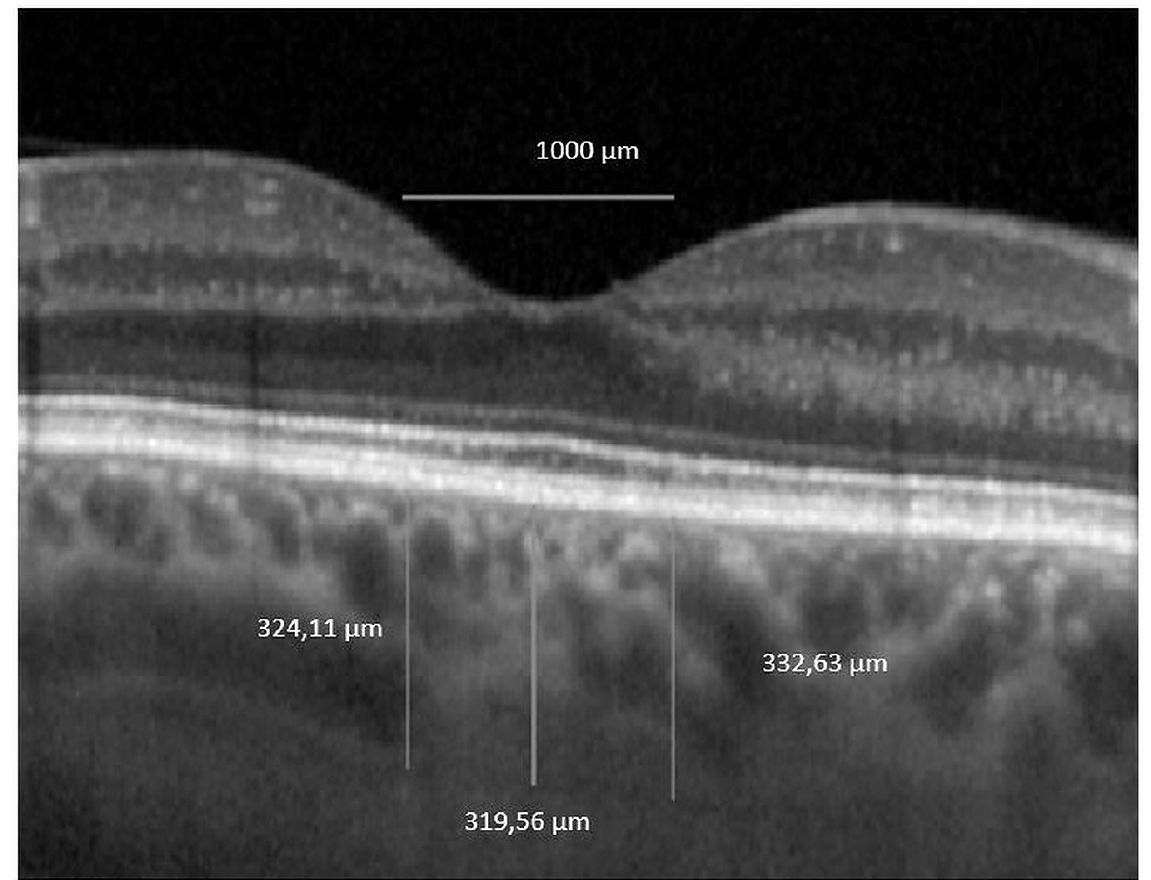
Figure 4. Foveal choroidal thickness. OCT 1 × 1 pixel * original image was uploaded in ImageJ software and 3 measurements were performed. * We used stretched 1 × 1 pixel images for illustrative purposes only, to help visualize the details of the retinal and choroidal structures.